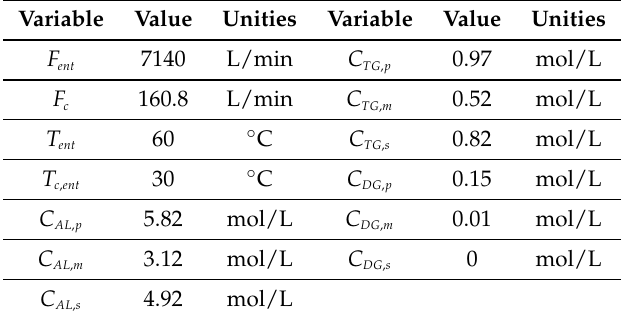
Table 3. Nominal operating conditions of the input